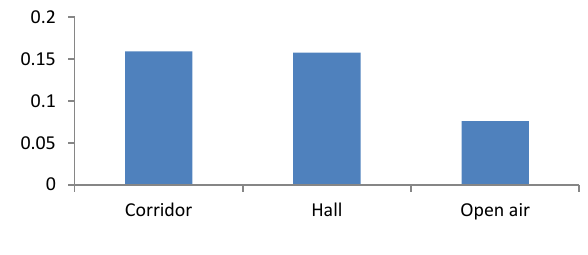
Figure 4. RSSI-D estimation error using DEUDHC